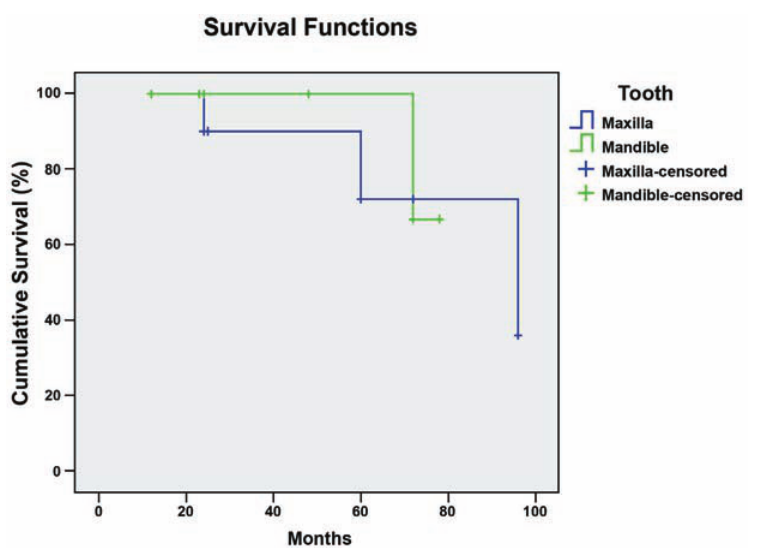
Figure 8- Survival functions of fiber-reinforced fixed partial dentures according to tooth location. Differences among curves were not statistically significant by Log Rank Test